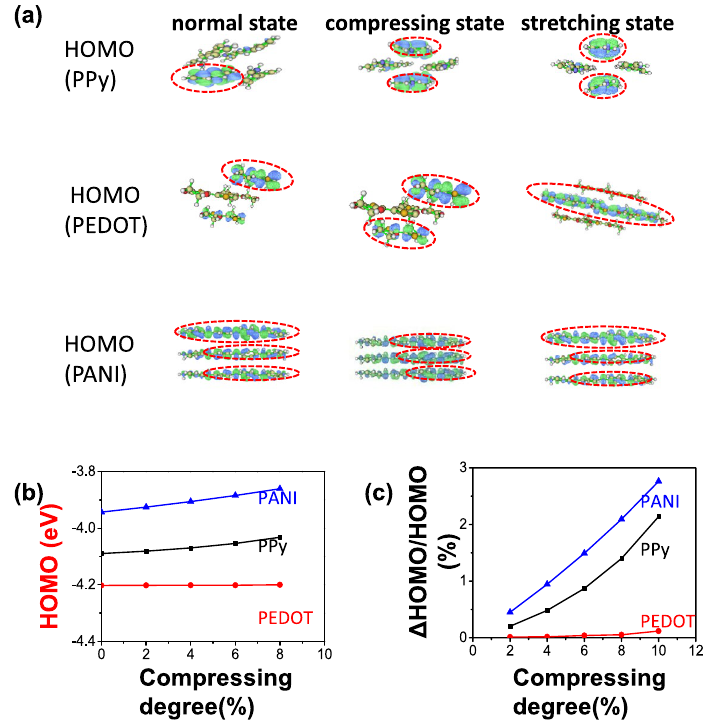
Figure 3. ( a ) The electronic densities distributions of HOMO of PPy (top panel), PEDOT (middle panel) and PANI (bottom panel) in normal state (left panel), compressing state (middle panel) and stretching state (right panel). ( b ) HOMO vs. deformations (2%, 4%, 6%, 8%,10%) for conductive polymer PPy, PEDOT and PANI. ( c ) The relative change in HOMO of PPy, PEDOT and PANI under